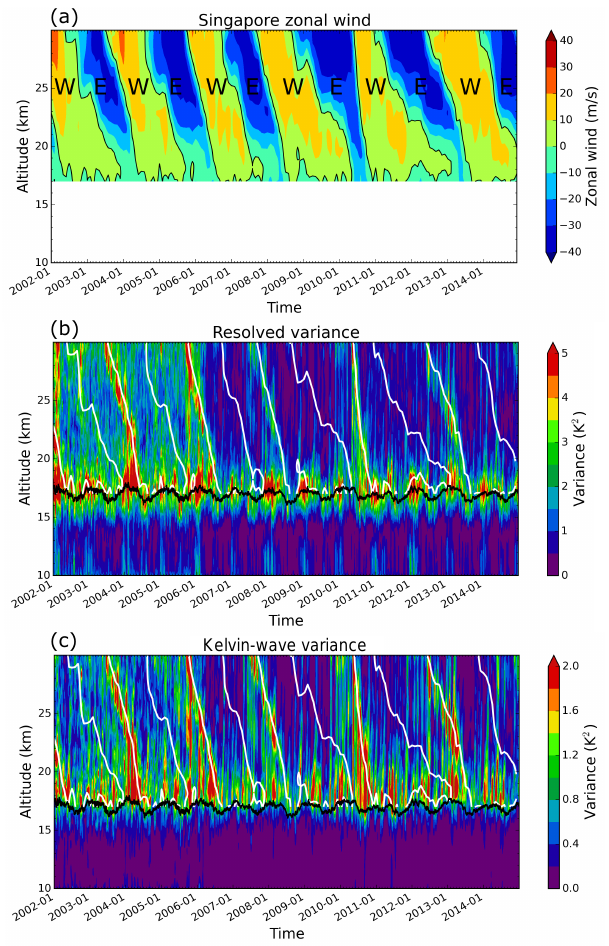
Figure 5. Time series of zonal mean wind speed above Singapore, smoothed resolved variance, and Kelvin-wave variance as a func- tion of altitude (top to bottom) from January 2002 to December 2014. E and W in the top panel refer to easterly and westerly wind. The thick black line in panels (b) and (c) indicates the lapse-rate tropopause, and thin white contour lines indicate zero zonal wind speed above Singapore. Note the different color scales in panels (b) and (c) .